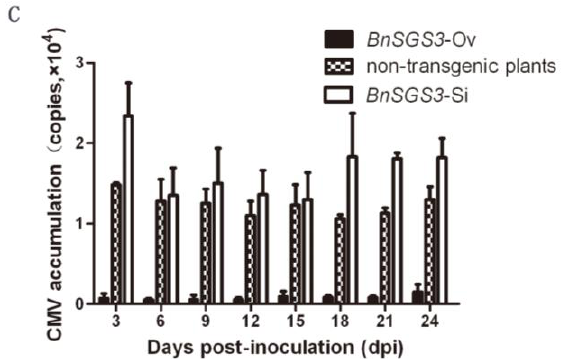
Figure 5. Accumulation of ORMV ( A ), TuMV ( B ) and CMV ( C ) in the transgenic and non-transgenic oilseed rape plants.